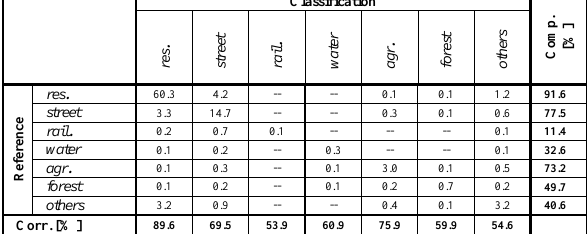
Table 2: Confusion matrix (in [%] of the total number of objects used for testing), completeness (comp.) and correctness (corr.) values [%] for the land use classes res. , street , rail. , water , agr. , forest and others obtained by classification applying the two-layer CRF approach based on superpixels of size 20 x 20.